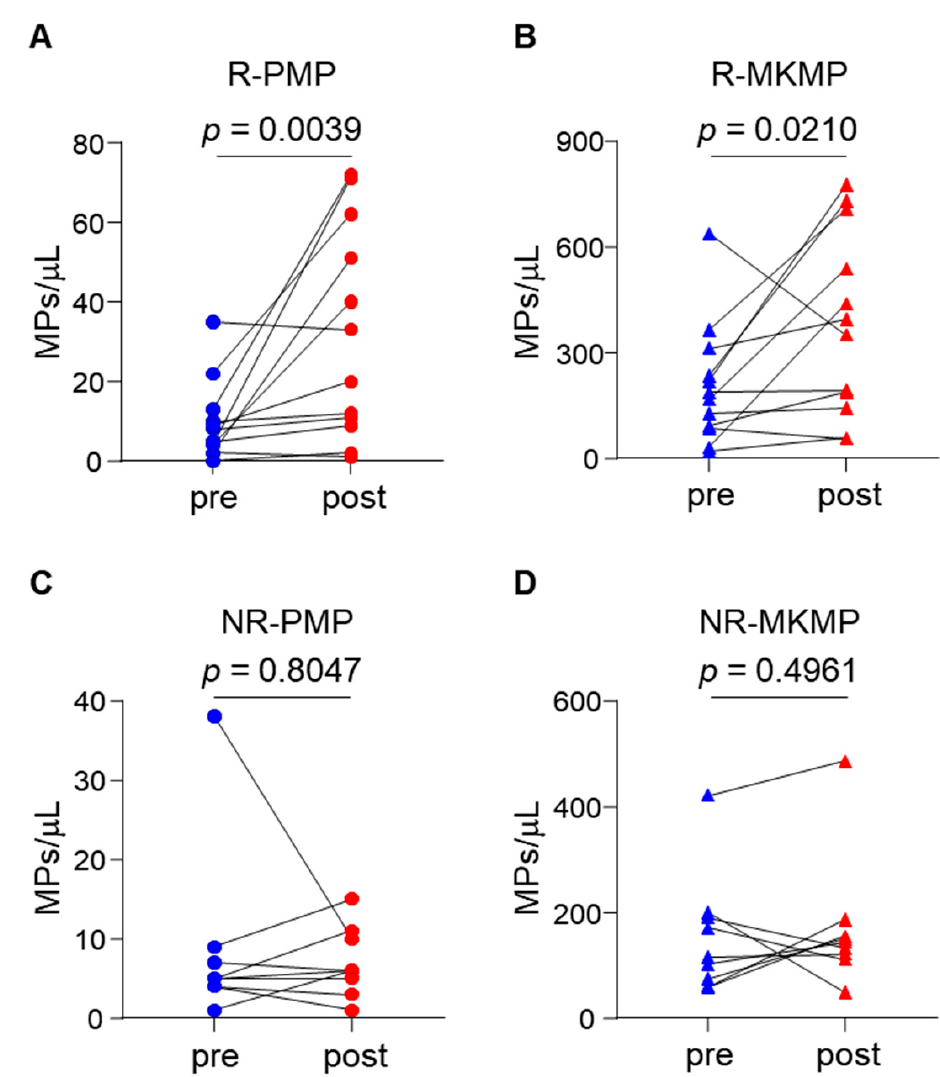
Figure 4. Plasma MPs levels before and after TPO-RA treatment. Plasma PMP and MKMP levels were measured before and after TPO-RA treatment in responders ( A , B ) and non-responders ( C , D ). Wilcoxon matched pairs t -test was performed for the comparisons between pre- and post-treatment groups.